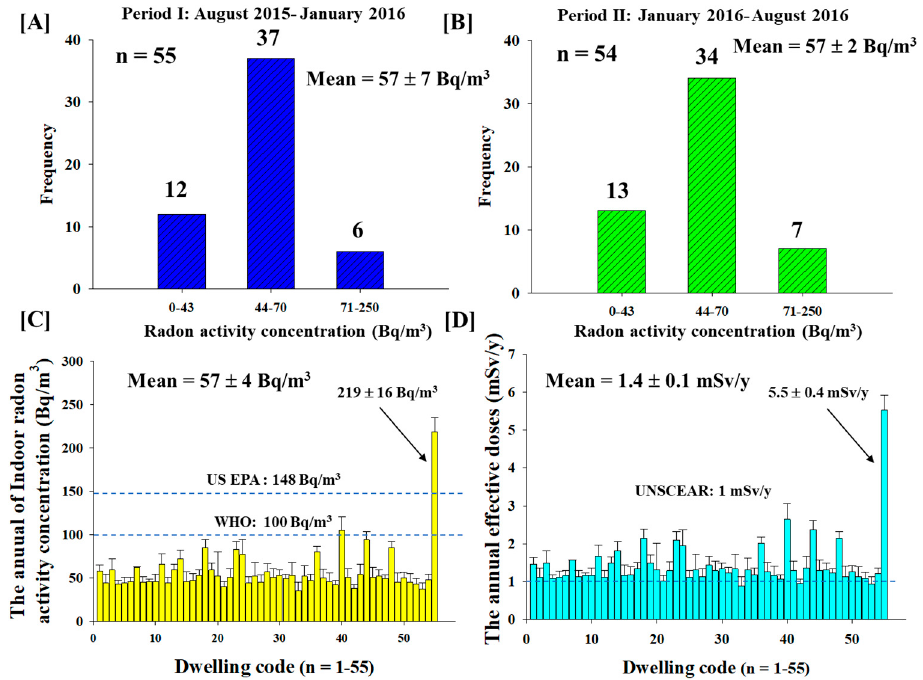
Figure 2. The radon activity concentrations and the effective doses of inhalation. ( A ) Distribution of the radon activity concentrations in Chiang Mai from August 2015 to January 2016. ( B ) Distribution of the radon activity concentrations in Chiang Mai from January to August 2016. ( C ) One-year average of radon activity concentrations in 55 Chiang Mai dwellings. ( D ) Annual mean effective dose for inhalation dose in 55 Chiang Mai dwellings.